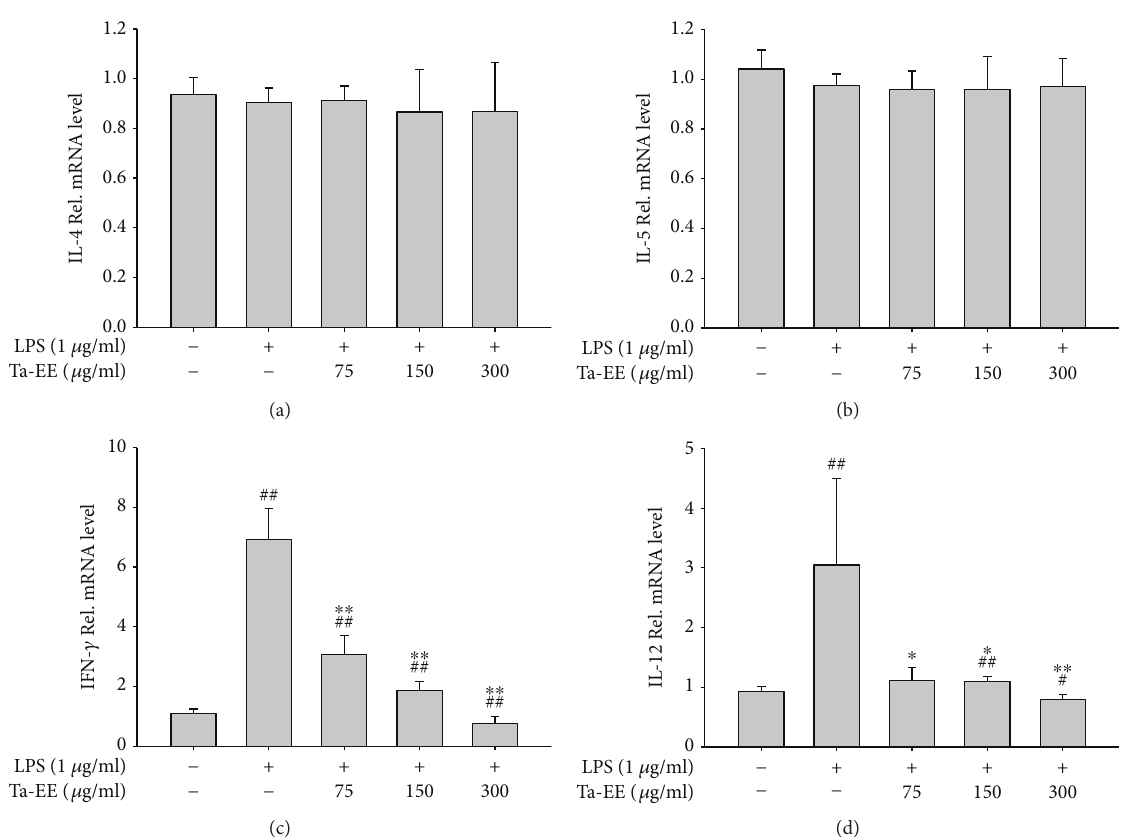
Figure 5: E ff ects of Ta-EE on mRNA expression of proin fl ammatory cytokines in LPS-stimulated splenocytes. The total splenocytes isolated from the spleens of normal mice were pretreated with Ta-EE (0, 75, 150, and 300 μ g/ml) for 30 min with LPS (1 μ g/ml) for 6h. The mRNA expression levels of (a) IL-4, (b) IL-5, (c) IFN- γ , and (d) IL-12 in the splenocytes were determined by quantitative real-time PCR. ∗ P < 0 05 and ∗∗ P < 0 005 versus a control group; # P < 0 05 and ## P < 0 005 versus a normal